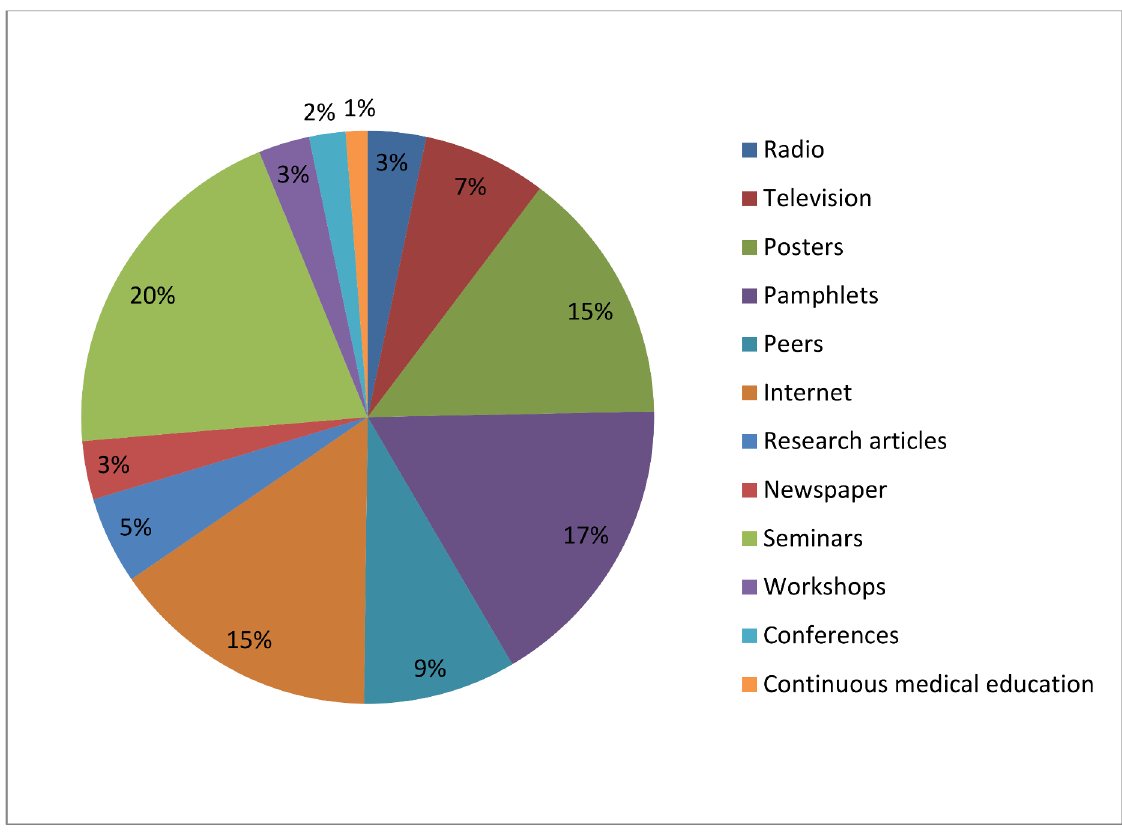
Fig 1. Healthcare workers sources of information about